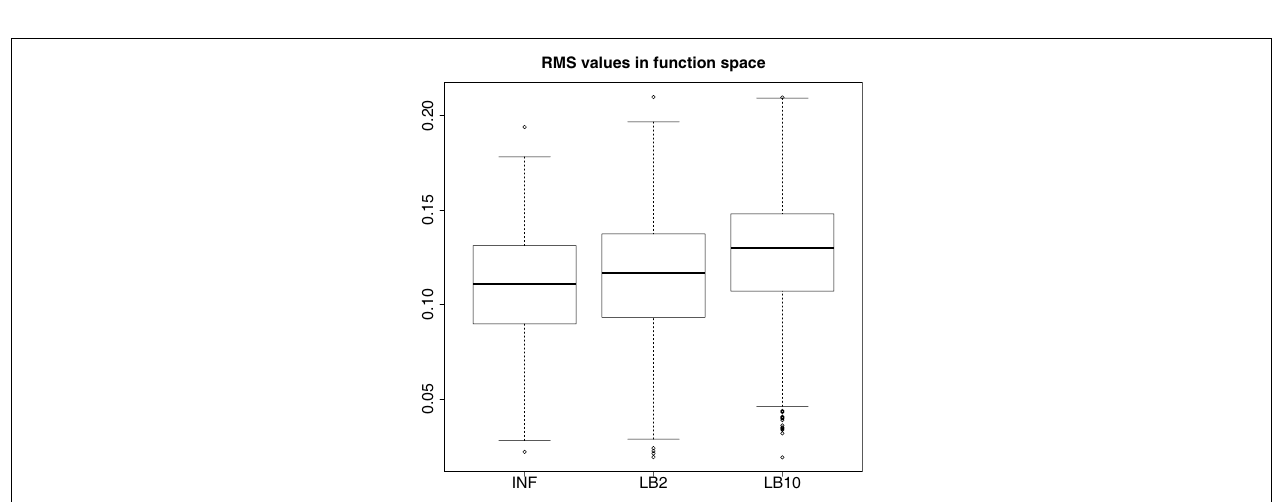
FIGURE 13 | Posterior distributions of RMS values for the ODE model in equations (63)–(67) . The RMS values are calculated on the residuals of the true signal (signal produced with true parameters and no observational error) minus the signal produced from the sampled parameters. For an explanation of the boxplot form, see the beginning of Section